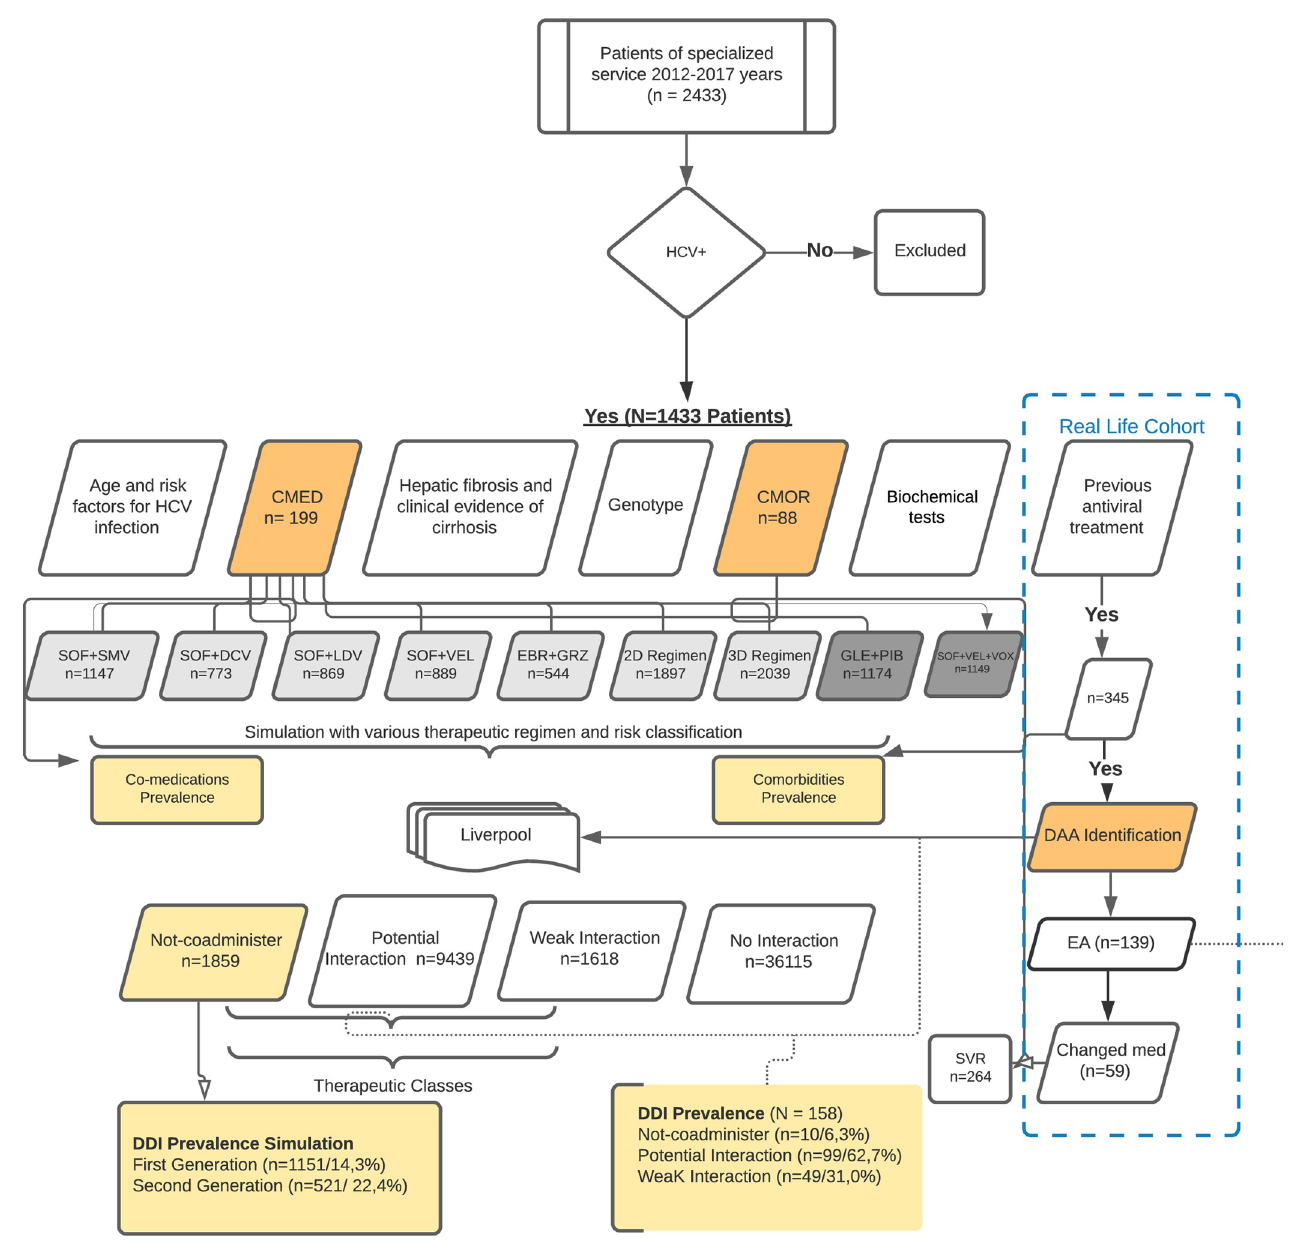
Fig 1. Flow diagram. Legend: HCV+ = hepatitis C viral positive; CMED = co—medications; CMOR = comorbidities; SVR = sustained virological response; Light grey box = first-generation pangenotypic DAAs; SOF+SMV = sofosbuvir and simeprevir; SOF+DCV = sofosbuvir and daclatasvir; SOF +LDV = sofosbuvir and ledipasvir; SOF+VEL: sofosbuvir and velpatasvir; EBR+GZR = elbasvir and grazoprevir; 2 D Regimen = OBV/PTV/r = ombitasvir, paritaprevir and ritonavir (r); 3D Regimen = 2D+DSV = ombitasvir/paritaprevir/r/dasabuvir; Dark grey box: second generation DAAs; GLE+PIB: glecaprevir/ pibrentasvir; SOF+VEL+VOX = sofosbuvir/velpatasvir/voxilaprevir; DAA = direct-acting antivirals; EA = adverse events; med = medications; Dark orange box = main variables; Light orange box = outcomes.